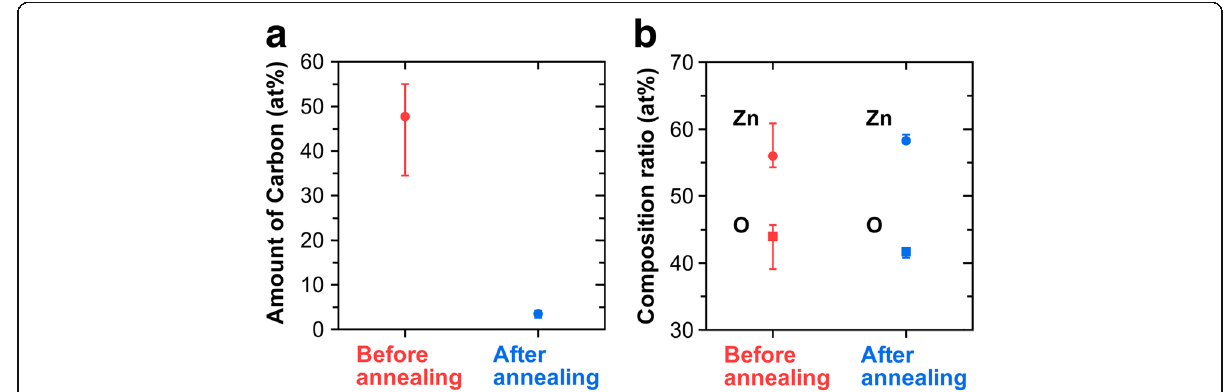
Fig. 5 Differences of the amount of carbon and composition ratio of ZnO before and after post-baking. The a amount of carbon and b compos- ition ratio of ZnO obtained by EDX analysis. These are the average values calculated from eight results detected in different observation points for both